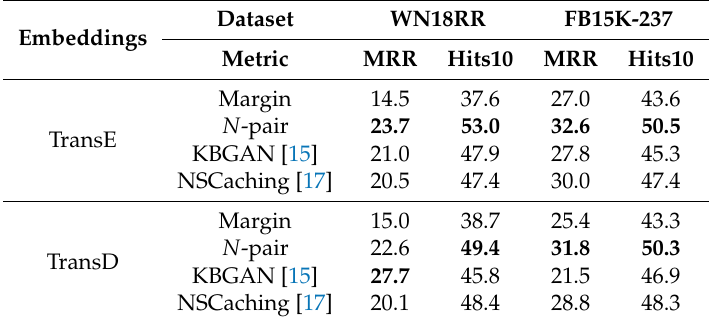
Table 2. Experimental results on link